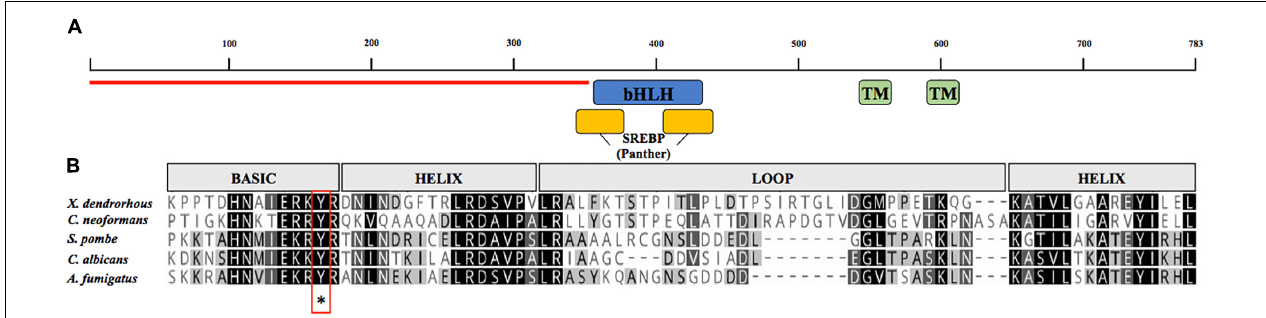
FIGURE 2 | Analysis of the amino acid sequence encoded by the SRE1 gene of X. dendrorhous . (A) Representation of the predicted conserved domains: two transmembrane domains (green; TMHMM database), the DNA binding domain type bHLH (blue; SMART database), sterol regulatory element-binding protein motif domain (yellow; PTHR12565, Panther database) and N-terminal domain rich in serine and proline residues (indicated with red line). (B) Alignment of bHLH domain of Sre1 from different fungi using Geneious Alignment tools with matrix Blossum62. The five sequences contain a conserved tyrosine residue (indicated by asterisk) specific to the SREBP family of bHLH transcription